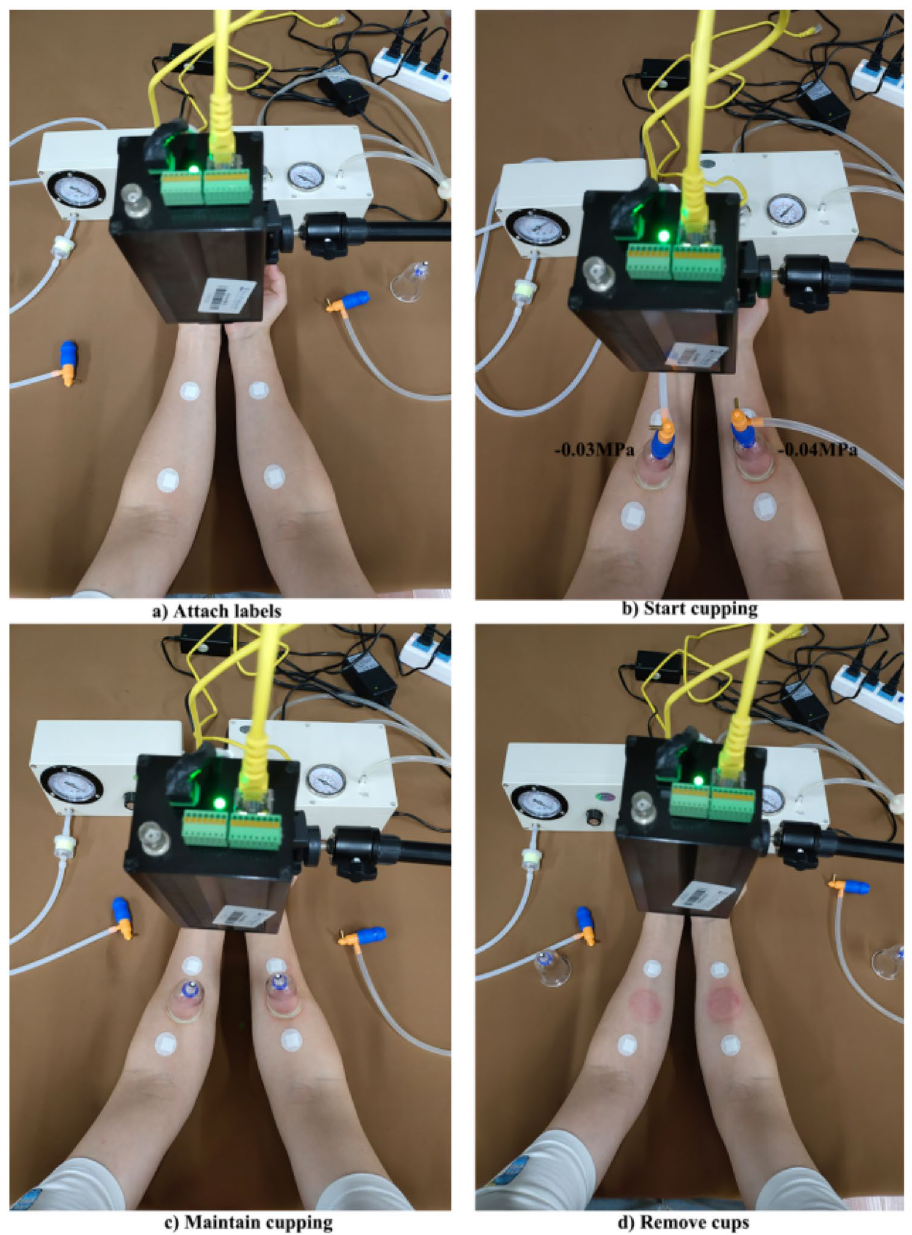
Figure 2. Complete process of the cupping test at two different negative